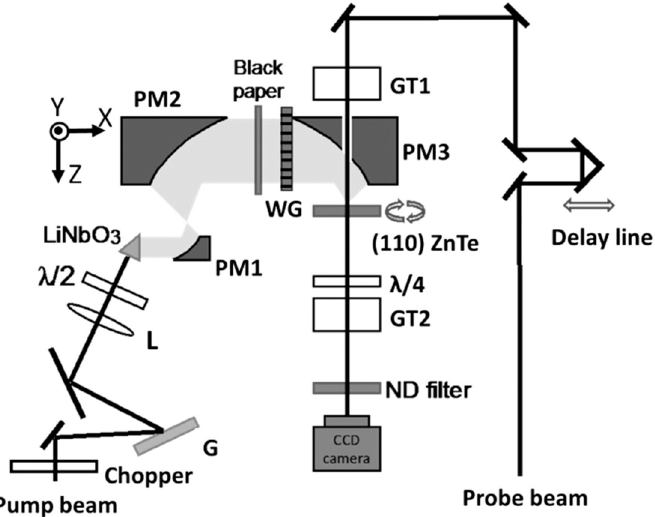
Figure 4. Experimental setup of the terahertz E-field vector imaging system. (Adapted from reference [62] with the permission of AIP Publishing.)